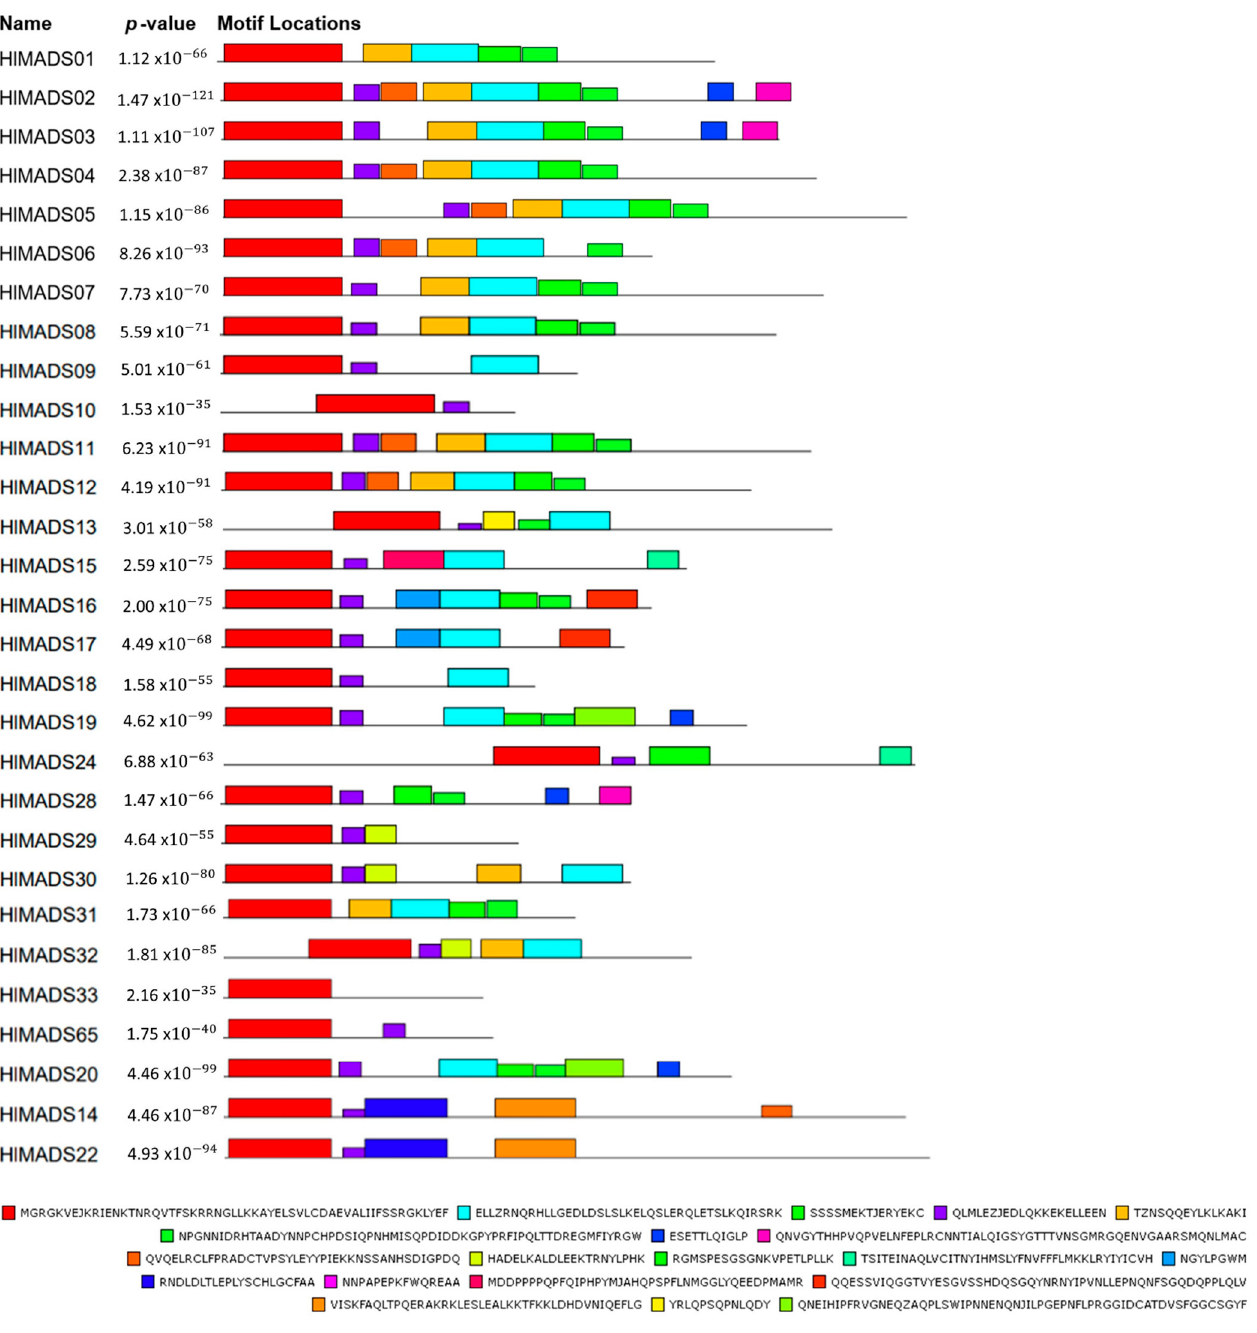
Figure 4. Motif distribution of hop type-I MADS-box proteins. Protein sequences are represented by black lines, and the conserved motifs are represented by colored boxes with the MADS-box domain in red.